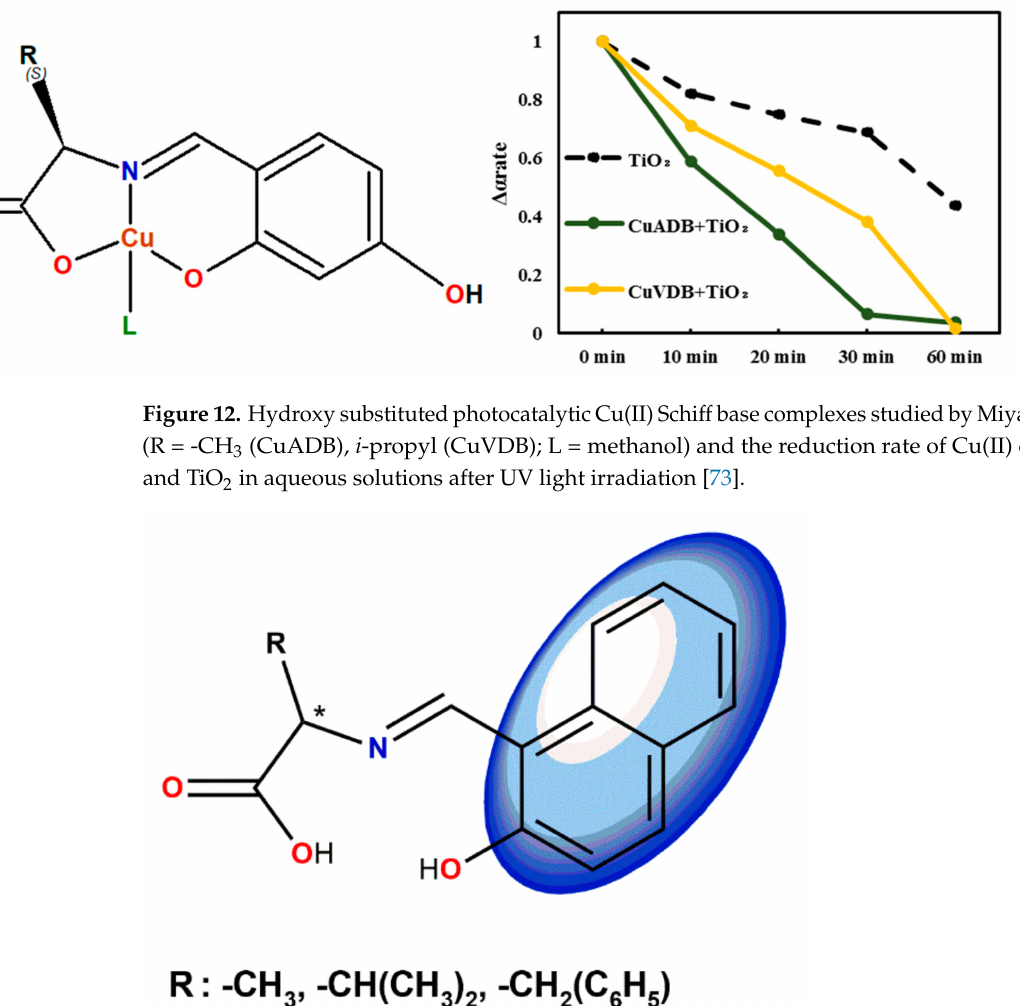
Figure 13. Amino acid Schiff base ligands with an extended π -conjugated system (* denotes an asymmetric carbon atom)